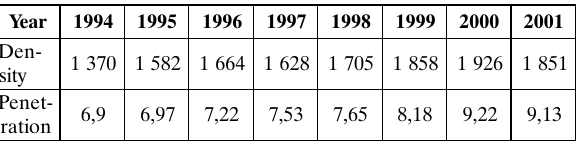
Table 5. Density and penetration indicators in EU (15) countries, in 1994–2001